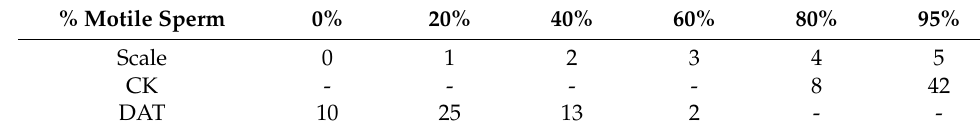
Table 1. Total-sperm-motility analysis using CASA system.